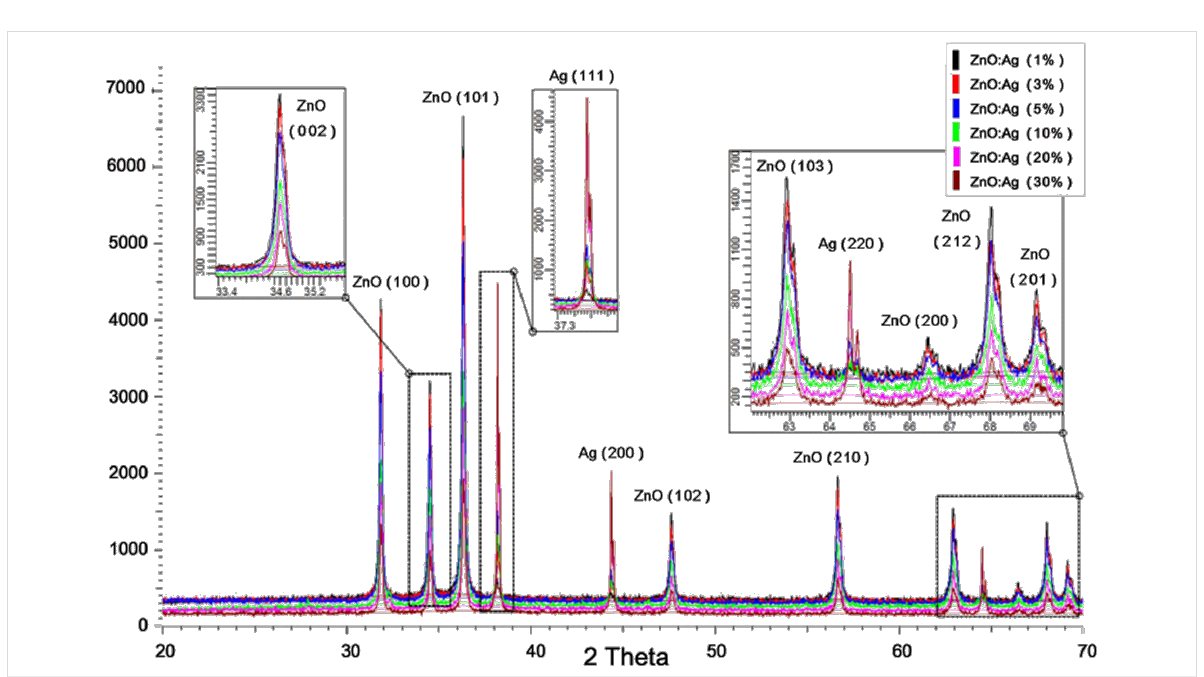
Figure 2: XRD patterns of different types of ZnO:Ag nanoparticles show the ZnO wurzite hexagonal crystalline structure and presence of the cubic crystalline form of Ag. Inset: magnified part of the spectrum showing the decrease in height of the ZnO peaks with an increase in the appearance of the Ag